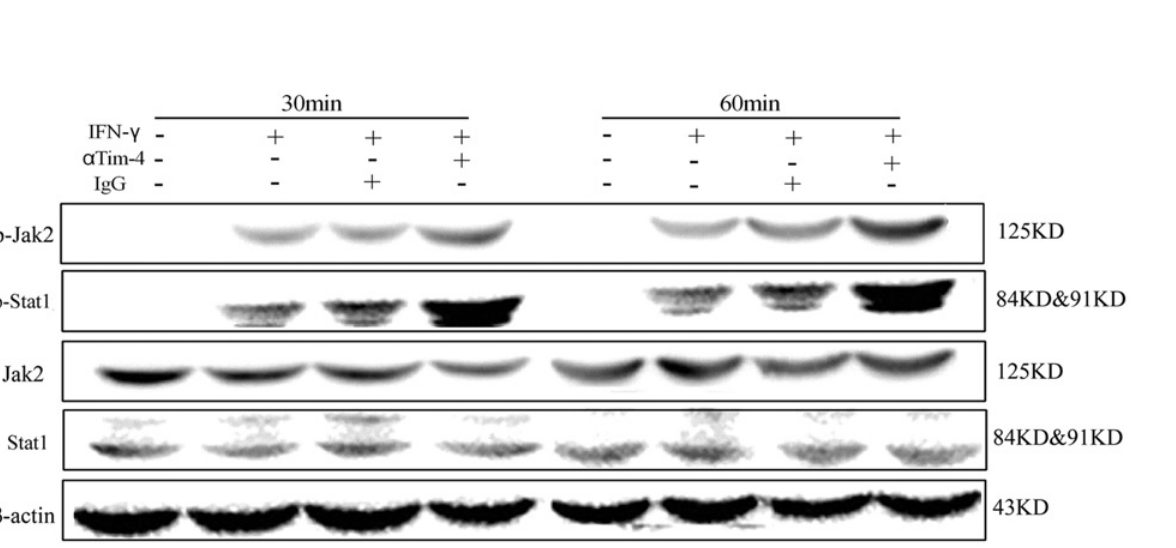
Fig 4. Tim-4 blocking promoted activation of Jak2-Stat1 pathway. Peritoneal macrophages were isolated from BALB/c mice and incubated with goat anti-mouse Tim-4 antibody or control IgG at 5 μ g/ml for 1 h, then stimulated with 100 U/ml IFN- γ for 30 min or 60 min. The levels of phosphorylated Stat1 and Jak2 were determined by immunoblotting. These experiments were repeated at least 3